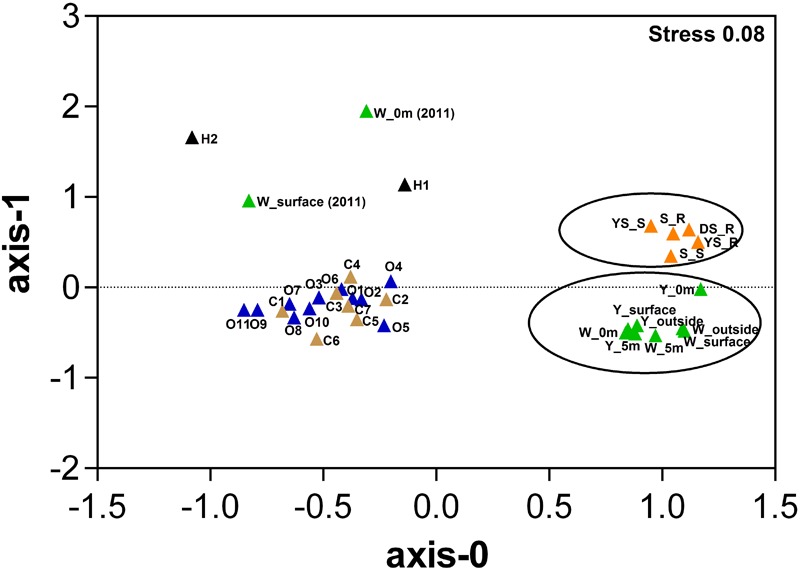
Multidimensional scaling plots of samples using Bray–Curtis similarity according to the SEED subsystem. Color represents different sample areas and each habitat label type (n) is indicated [data highlighted by two circles from this study; W_0m (2010) and W_surface (2010) data from our previous study (4) (Tang et al., 2013), H1 and H2 data from references (Grzymski et al., 2008; McDermott et al., 2015), other data from a reference (Rusch et al., 2007), Details in Supplementary Table S3. Samples from each of the respective environments clustered together based on their functional profile. The stress values are reported in the top right corner and represent the goodness-of-fit.